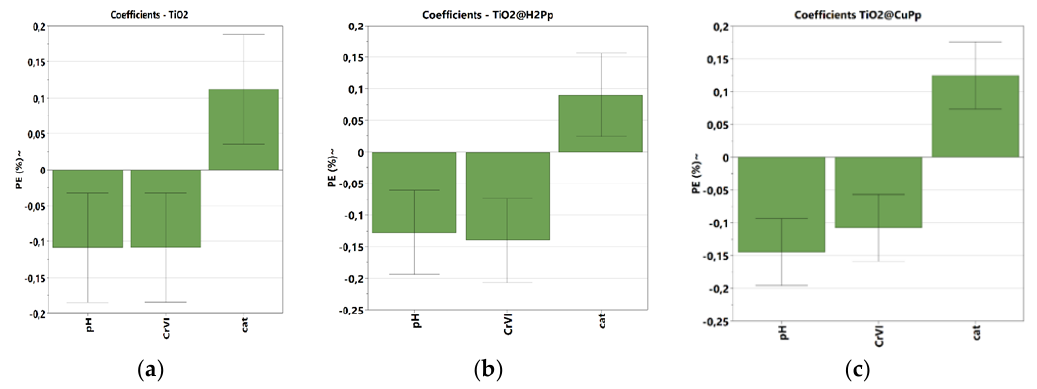
Figure 3 . Plots of the significant coefficients obtained for ( a ) TiO 2 , ( b ) TiO 2 @H 2 Pp, and ( c ) TiO 2 @Cu(II)Pp catalysts.